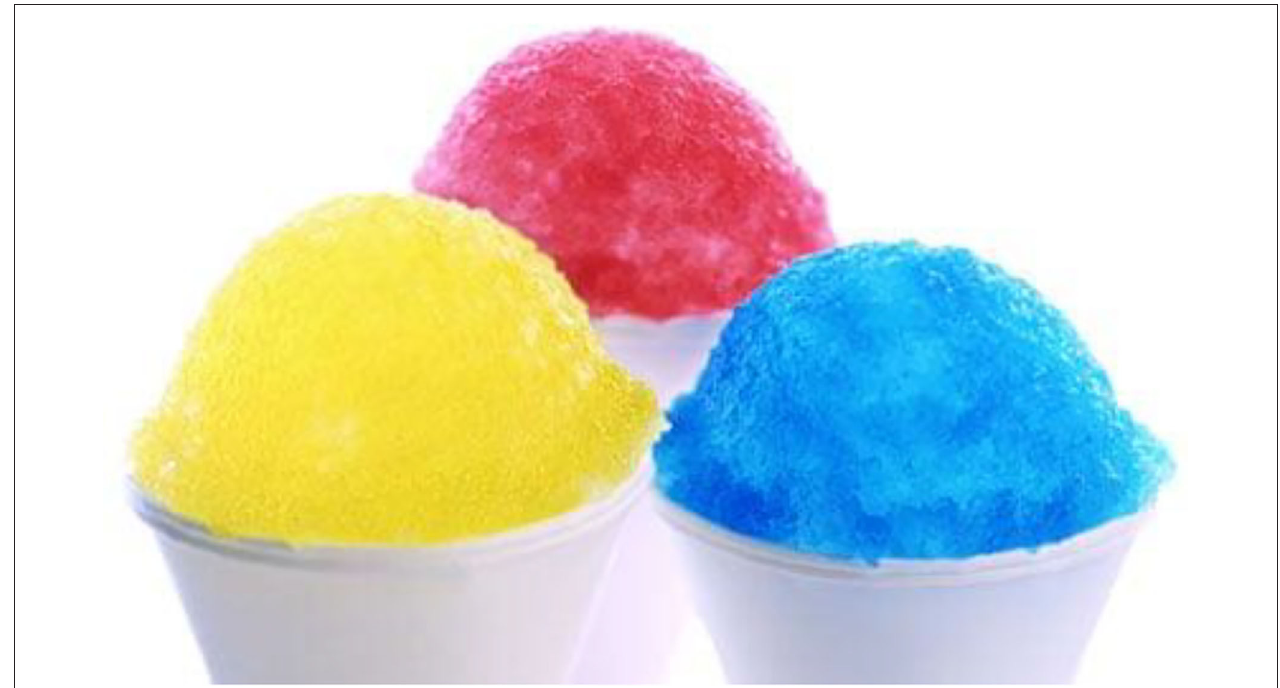
FIGURE 1 | Yellow, red, and blue: how would you expect them to taste? (Photo from Kathyn Russell Studies, coutesy of Getty Images).